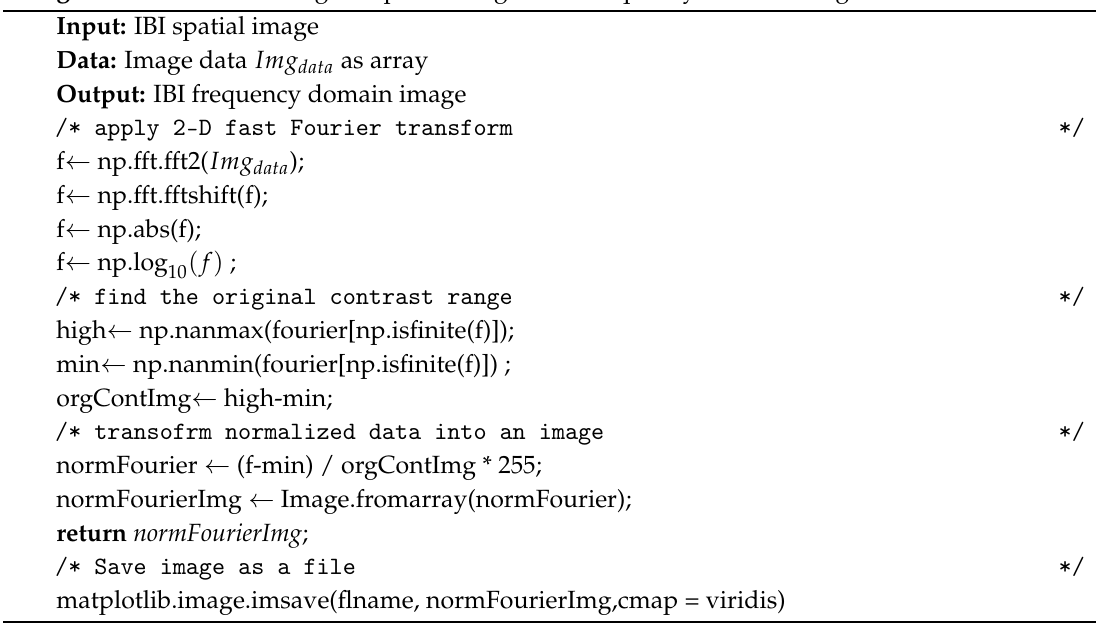
Algorithm 1: Transforming IBI spatial images into frequency domain